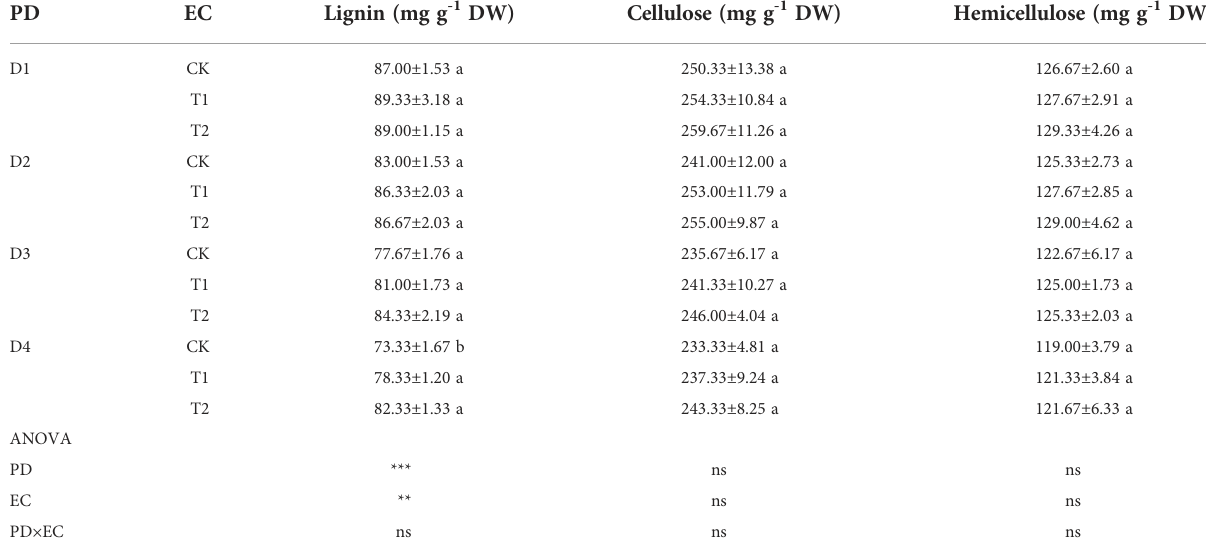
TABLE 6 Effects of EC and PD on lignin, cellulose, and hemicellulose in the basal stem below the ear in 2021.